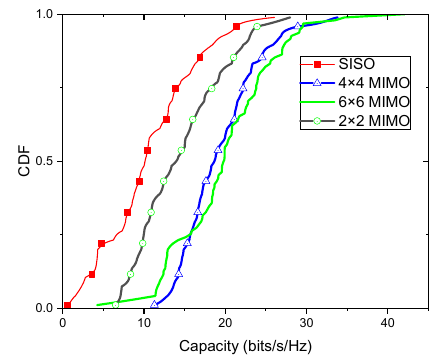
Fig. 6. CDF capacity between different MIMO